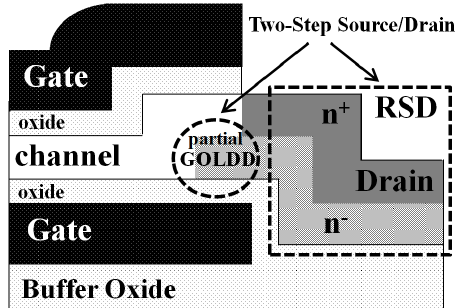
Figure 1. Detailed design information for the double-gate two-step source/drain Poly-Si TFT.